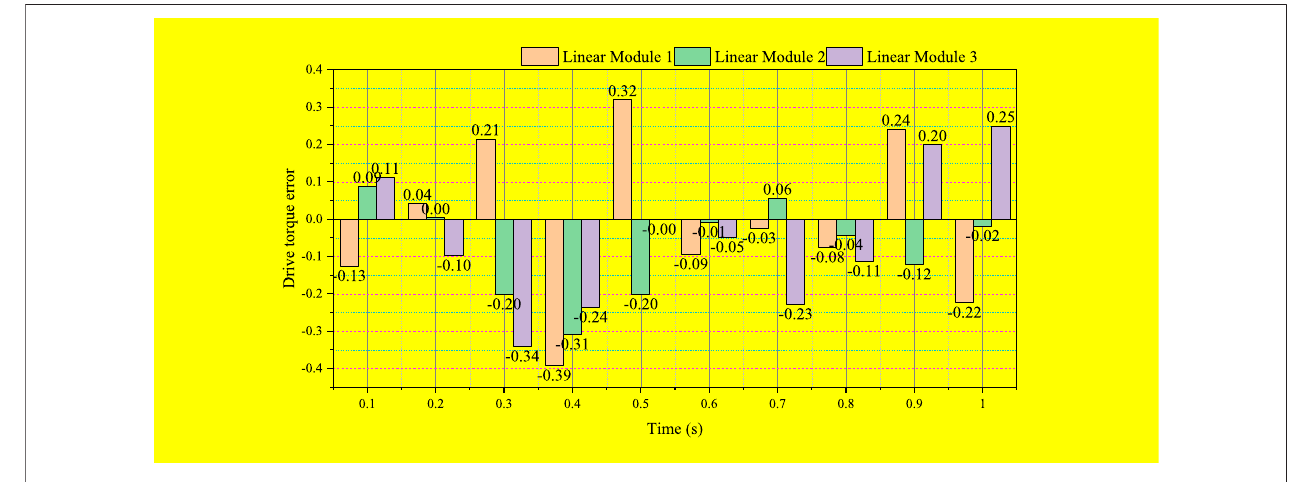
FIGURE 5 | Driving torque error of linear module of testing machine.